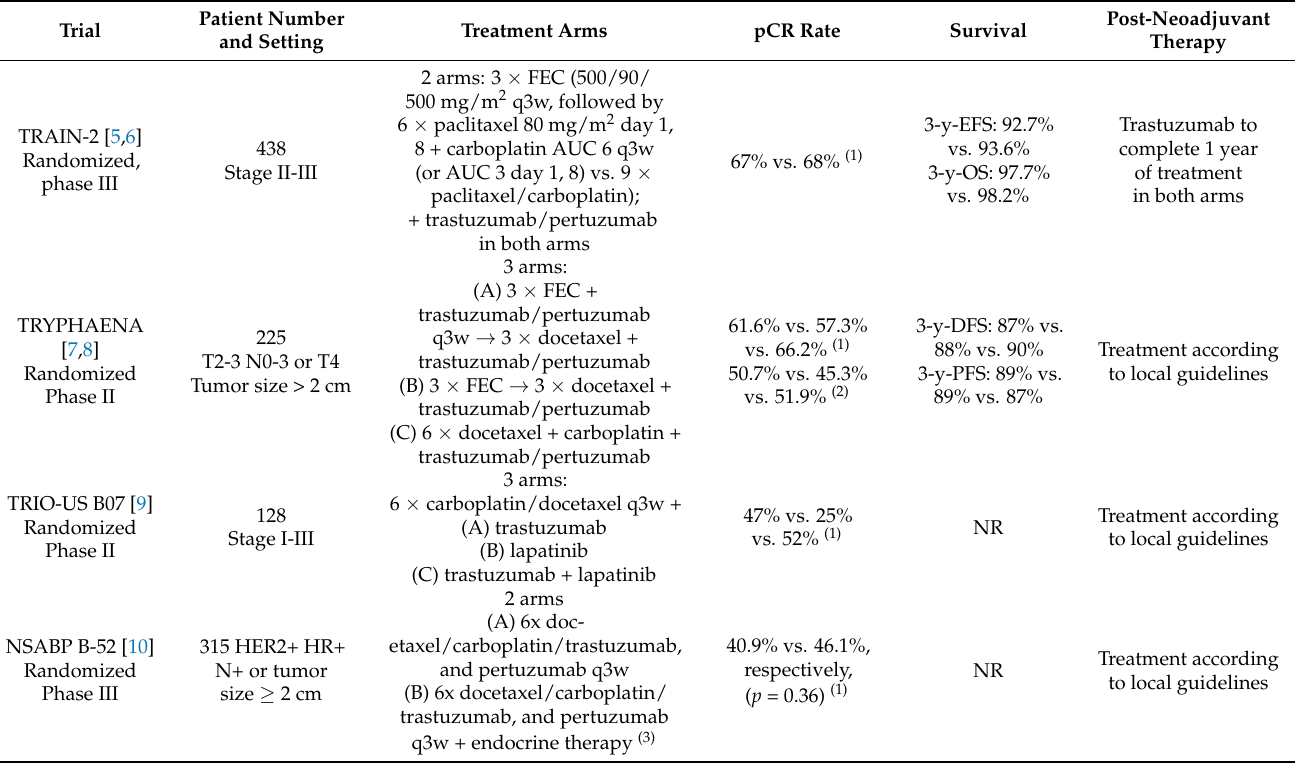
Table 1. The major clinical studies on neoadjuvant therapy in HER2-positive non-metastatic breast cancer (only randomized phase II and III